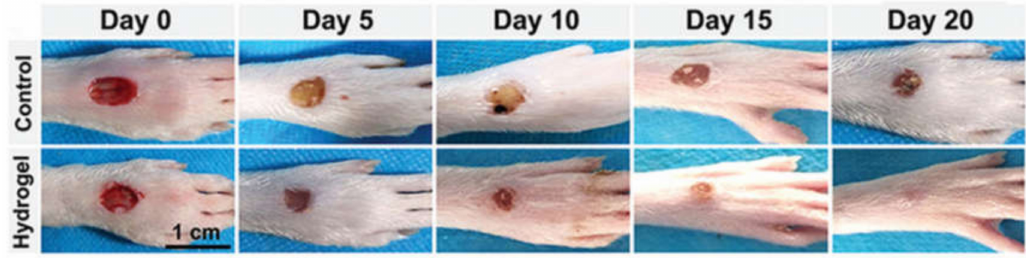
Figure 8. Representative photos of the diabetic foot in rats after being treated with the control group (PBS) or the conductive hydrogel containing PDA@Ag NPs [70]. Reprinted from [70] with permission from